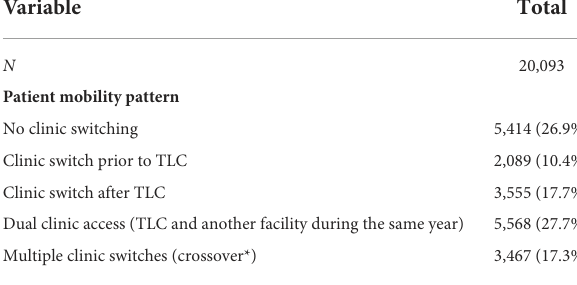
TABLE 5 Types of facility movement among Themba Lethu Clinic (TLC) patients ( n =